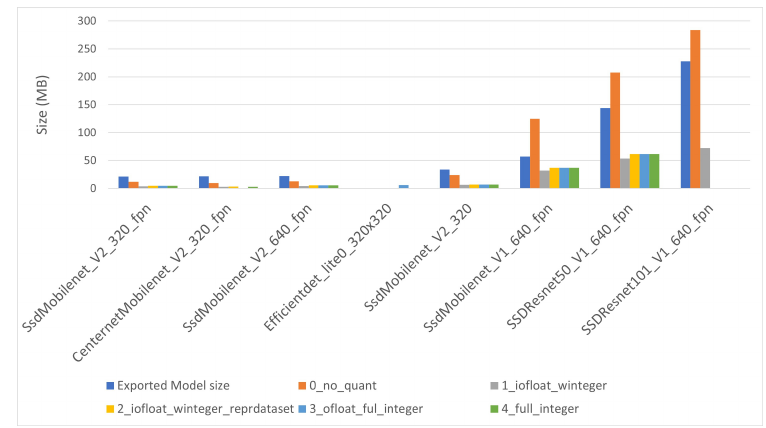
Figure 9. TensorFlow Lite converted file sizes for